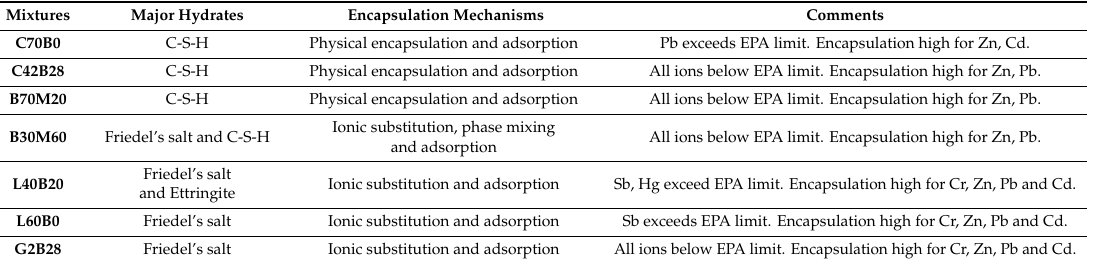
Table 5. Major hydrates and encapsulation mechanisms of representative